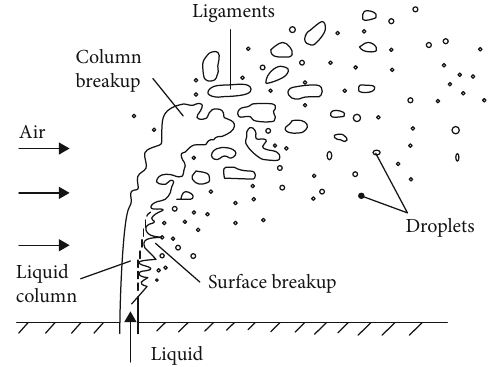
Figure 3: Schematic diagram of the breakup region of liquid jet injected into transverse air fl